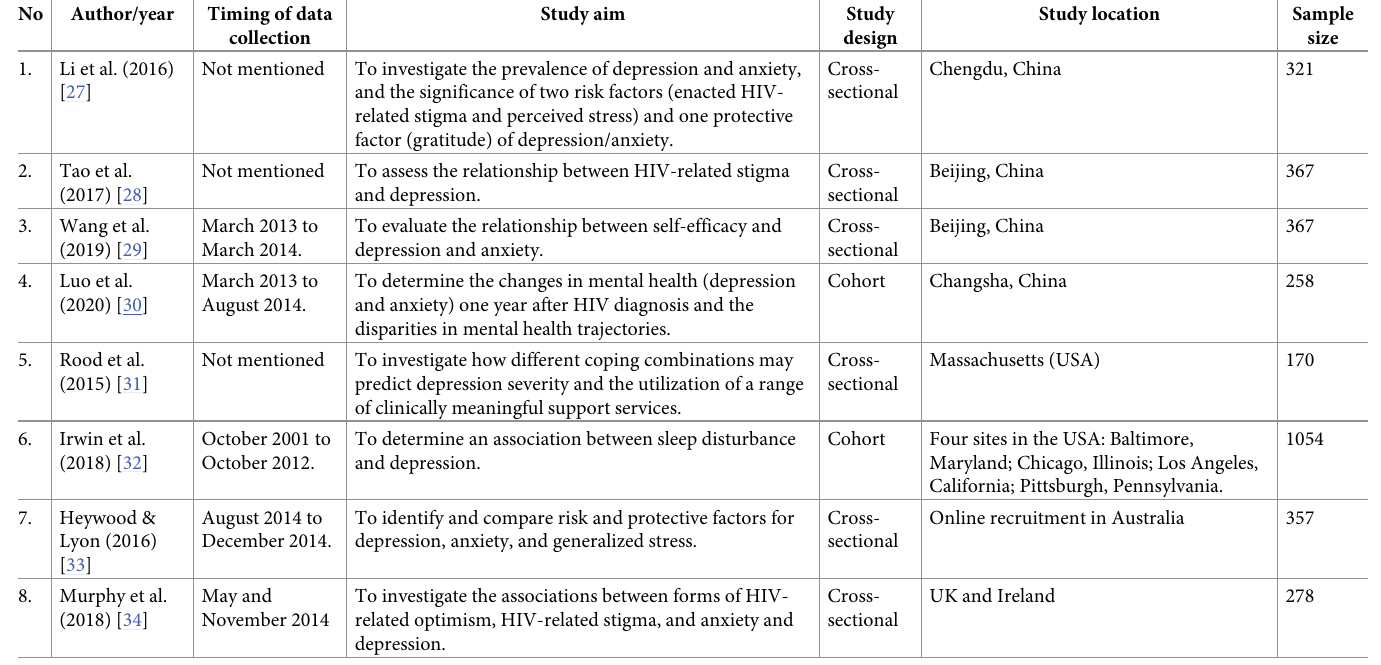
Table 1. Characteristics of selected articles.